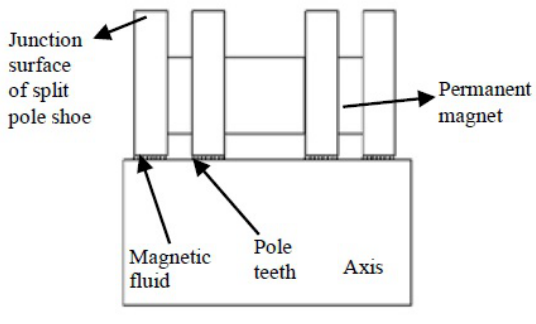
Fig. 3 Axial section diagram of optimised seal